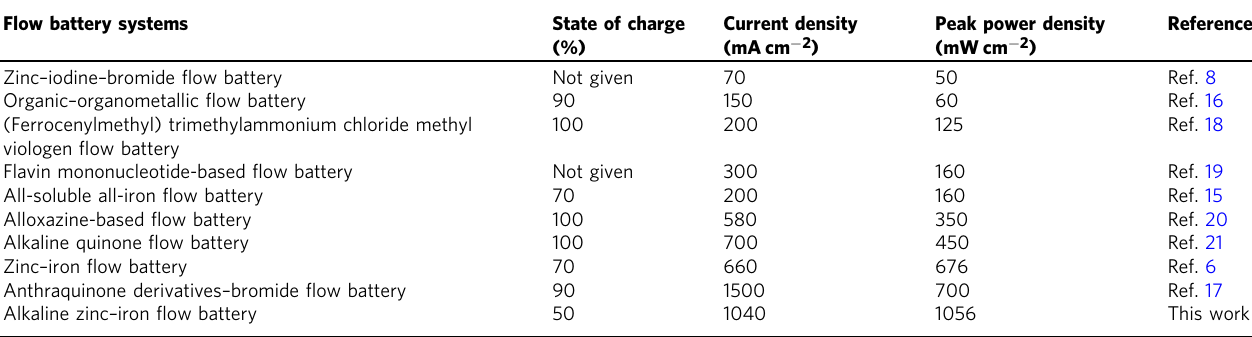
Table 1 Power density for different fl ow battery systems Flow battery